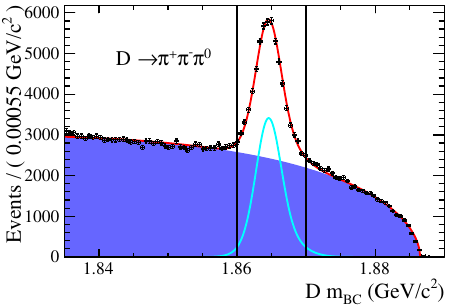
Figure 7 . The m bc distribution of selected (cid:25) + (cid:25) (cid:0) (cid:25) 0 single tagged candidates. Superimposed with a red line is the result of a unbinned maximum likelihood (cid:12)t described in the text. The shaded purple area shows the background PDF, and the blue line shows the signal PDF. The vertical lines show the signal